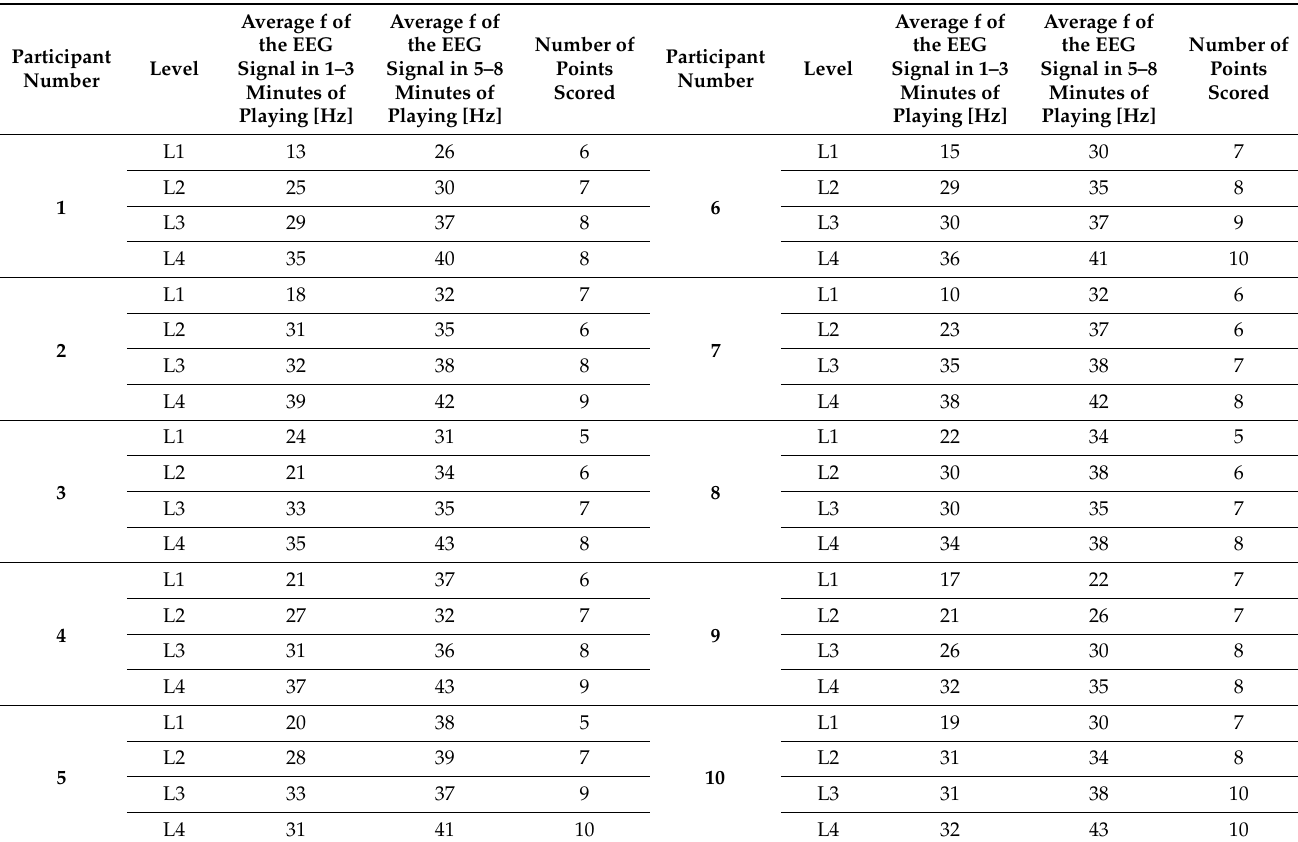
Table 1. Numerical data of the increase in the average frequency of the EEG signal and the number of points scored within the concentration level.